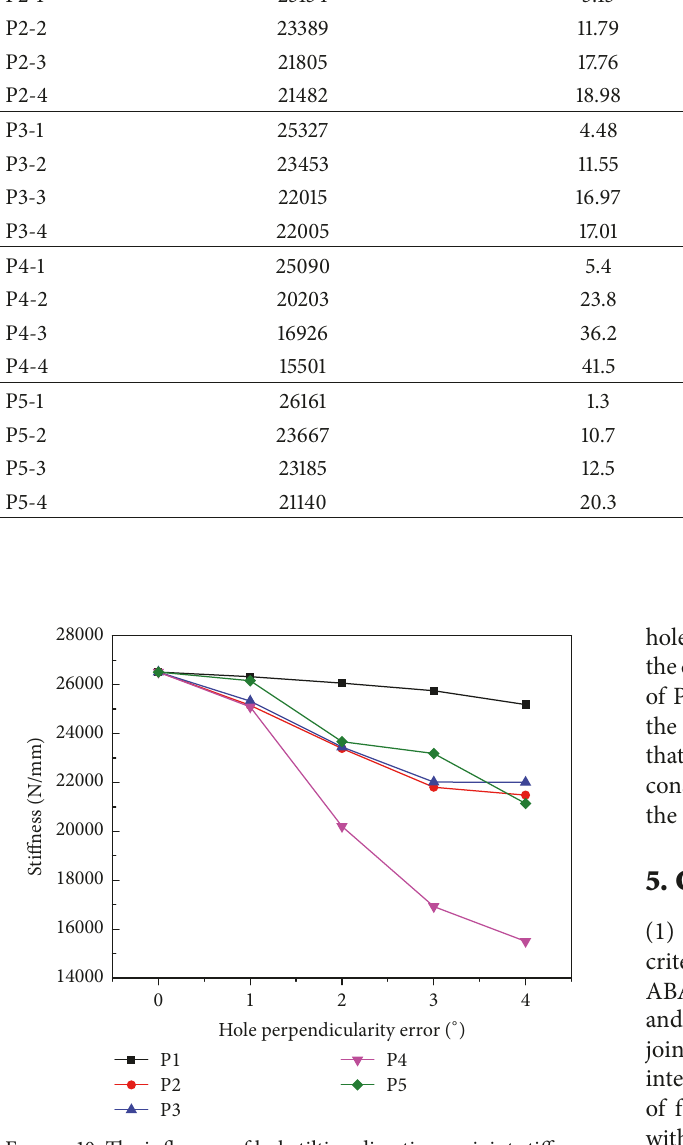
Figure 10: The influence of hole tilting direction on joint